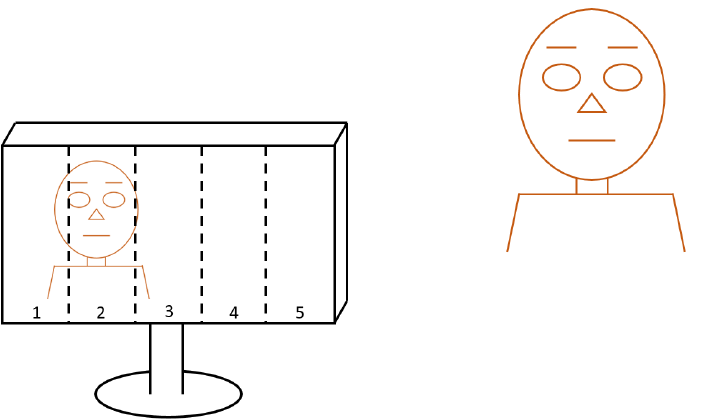
tion of the listener head is